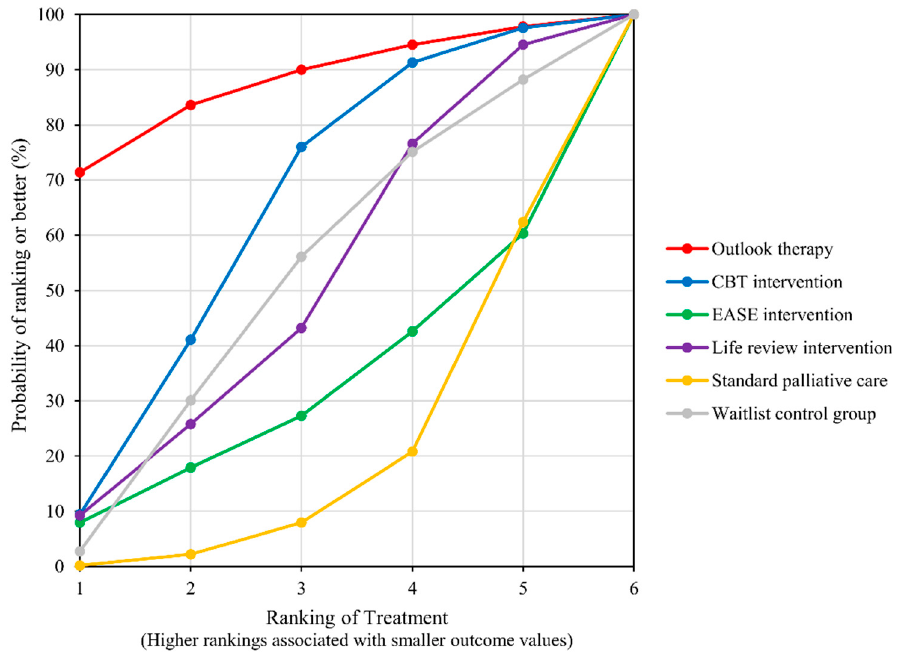
Figure 5. SUCRA plot for outcome of Depression.